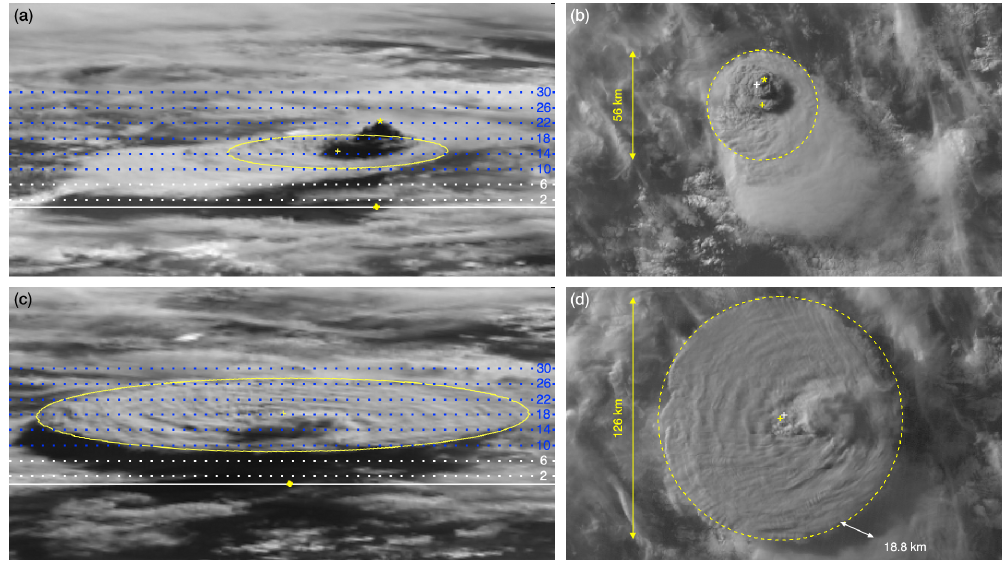
Figure 11. The 26 June 2019 eruption of Ulawun: GOES-17 band 2 fixed grid image (4 × magnification) at (a) 06:10UTC and (c) 07:00UTC and the corresponding Himawari-8 band 3 CEReS V20190123 image at (b) 06:10UTC and (d) 07:00UTC. The yellow diamond (GOES- 17) and white plus sign (Himawari-8) mark the volcano base, while the solid/dashed yellow line is a circle fitted to the umbrella cloud with a radius of 28km at 06:10UTC and 63km at 07:00UTC (the yellow plus sign is the circle center). The yellow asterisk indicates the overshooting top in the 06:10UTC images. In panel (d) , the white arrow depicts the length and direction of the shadow the upper umbrella cloud casts on the lower umbrella cloud. In panels (a) and (c) , the baseline (solid white) and selected isoheights (in km, dotted white/blue) are also drawn.